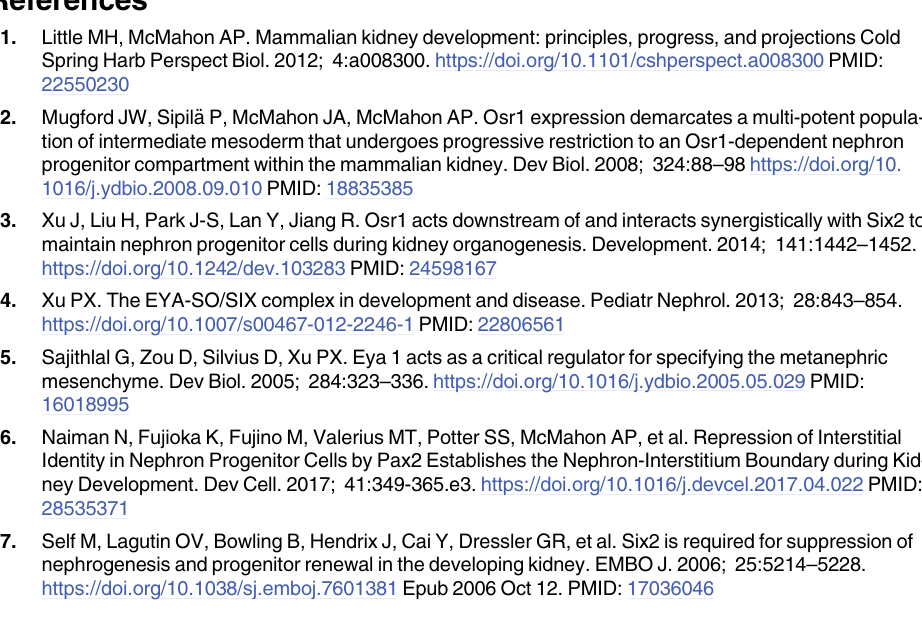
S3 Table. Genes expressed in Wilms cell lines ( < 1000) from all Hochane clusters. S4 Table. Marker genes for each Hochane cluster and highest expressed genes in Wilms cell lines. S5 Table. Genes expressed in Wilms cell lines ( < 1000) from all Wang clusters. (XLSX) S6 Table. Marker genes from Wang clusters and highest expressed genes in Wilms cell